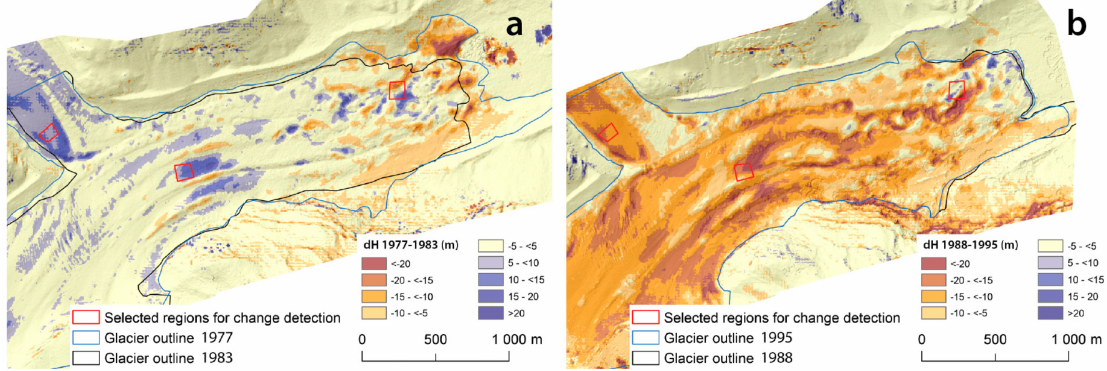
Figure 7. Heterogeneous elevation change patterns in different periods: 1977–1983 ( a ) and 1988–1995 ( b